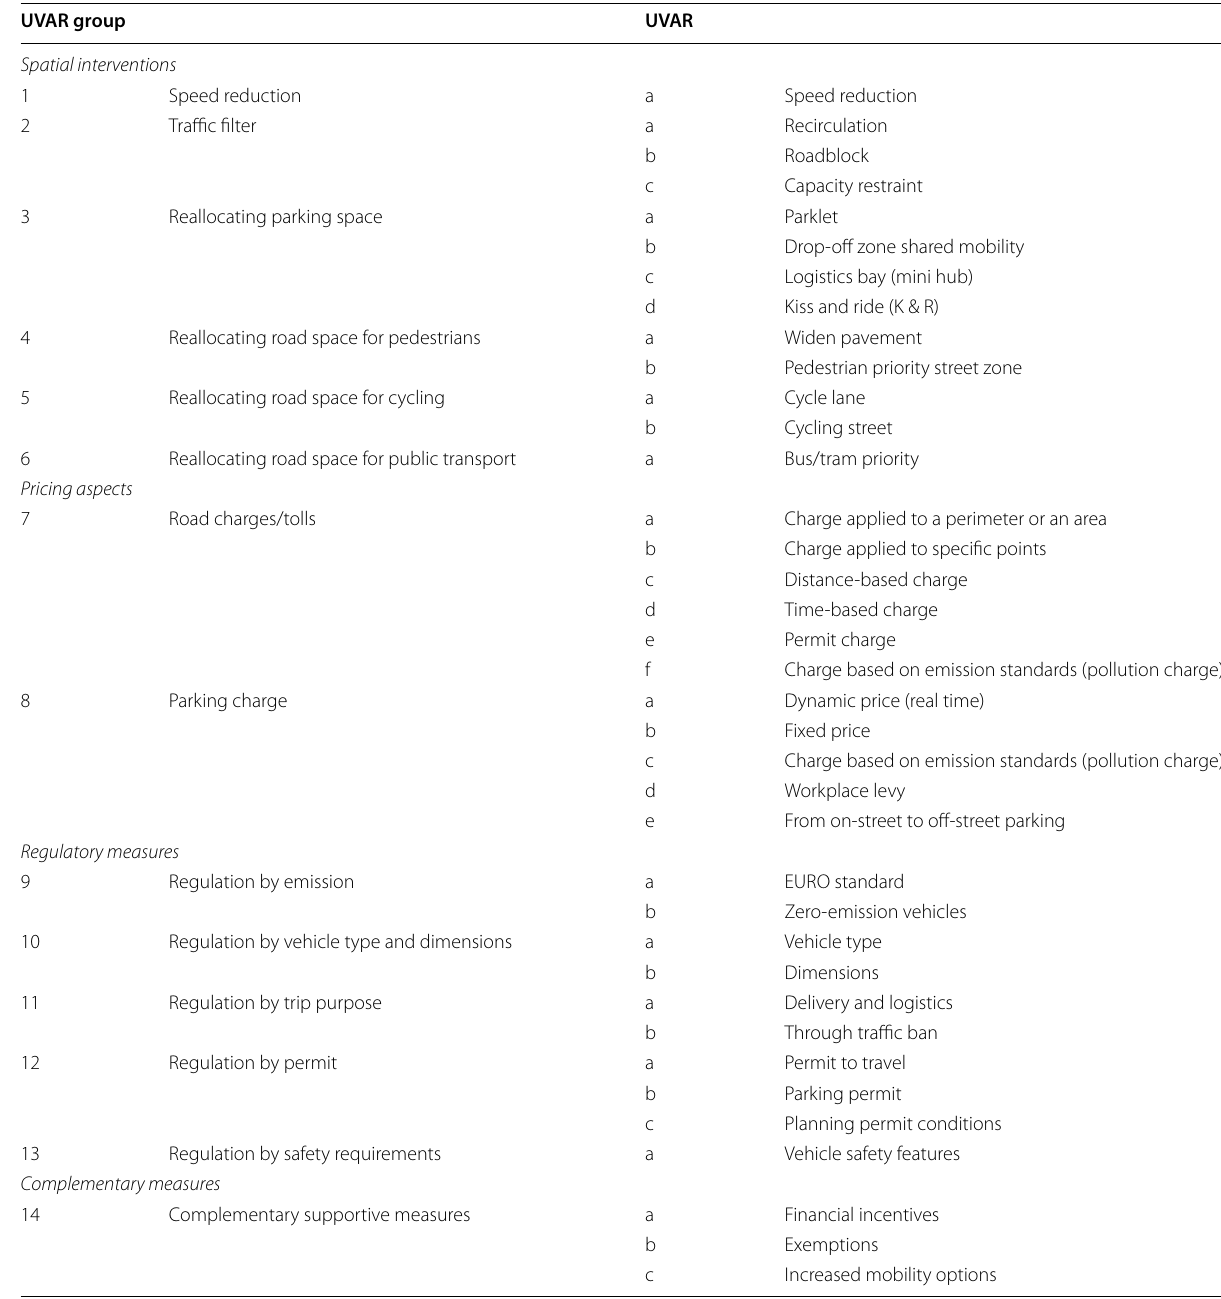
Table 5 UVAR taxonomy structure for the case study analyses, indicating the possible UVAR measures in the UVAR categories (spatial interventions, pricing aspects and regulatory measures) and the complementary supportive measures UVAR group UVAR Spatial